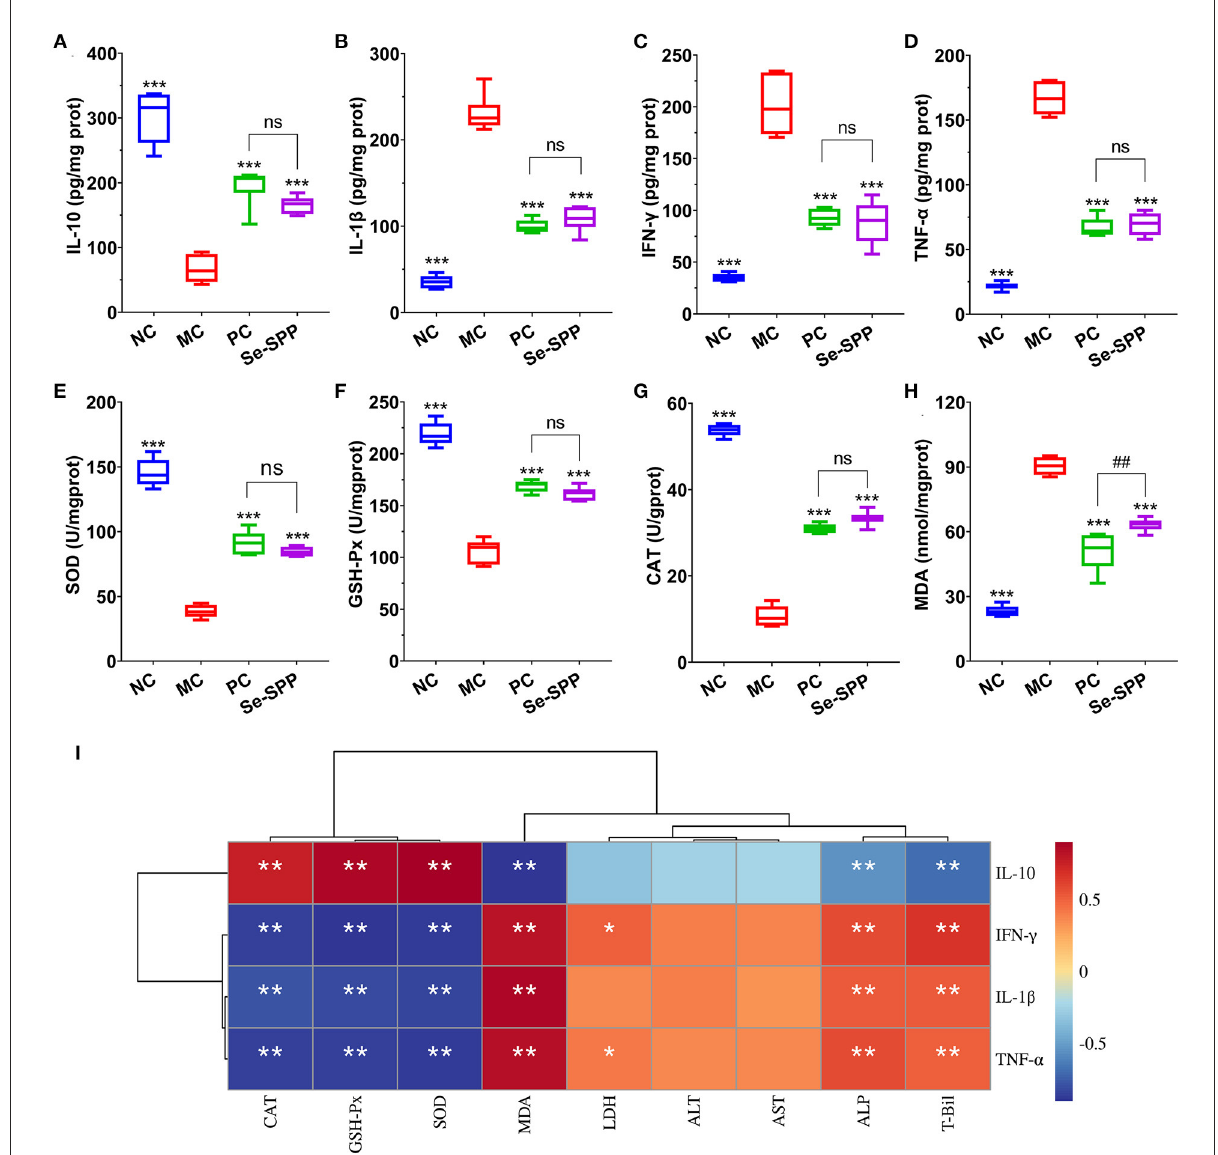
FIGURE2 Se-SPP alleviates Cd-induced liver inflammation in mice. Liver TNF- α , IL-1 β , IFN- γ , and IL-10 levels (A–D) ; liver GSH-Px, SOD, CAT, and MDA levels (E–H) ; and correlation analysis between the inflammatory-related factors and antioxidant indexes (I) . NC, normal control; MC, model control; PC, positive control; Se-SPP, selenium-containing polysaccharides from Spirulina platensis . TNF- α , tumor necrosis factor; IL-1 β , interleukin-1 beta; IFN- γ , interferon- γ ; IL-10, interleukin-10; GSH-Px, glutathione peroxidase; SOD, superoxide dismutase; CAT, catalase; MDA, malondialdehyde. Data are expressed as mean ± SEM ( n = 6). Graph bars marked with ns: not significant,* p < 0.05, ** p < 0.01, *** p < 0.001 when compared with MC; # p < 0.05, ## p < 0.01, ### p < 0.001 when comparing PC with Se-SPP. The colors range from red (positive correlation) to dark blue (negative correlation), and significant correlations are marked with * p < 0.05, ** p < 0.01, *** p <